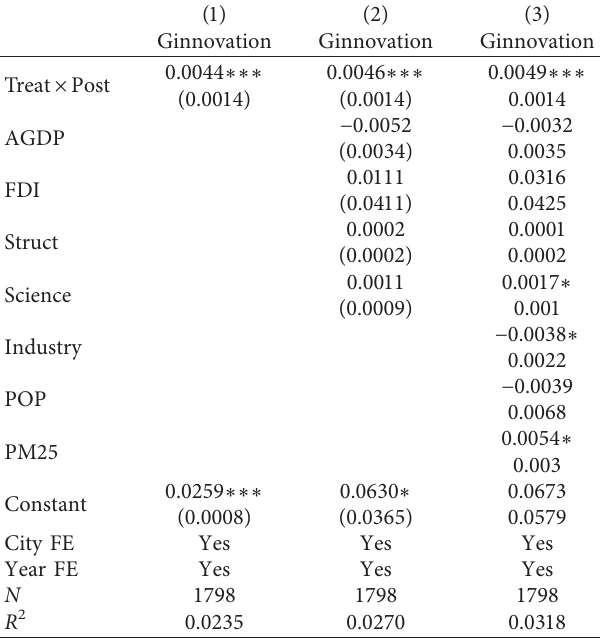
Table 3: The impact of the new environmental protection law on green